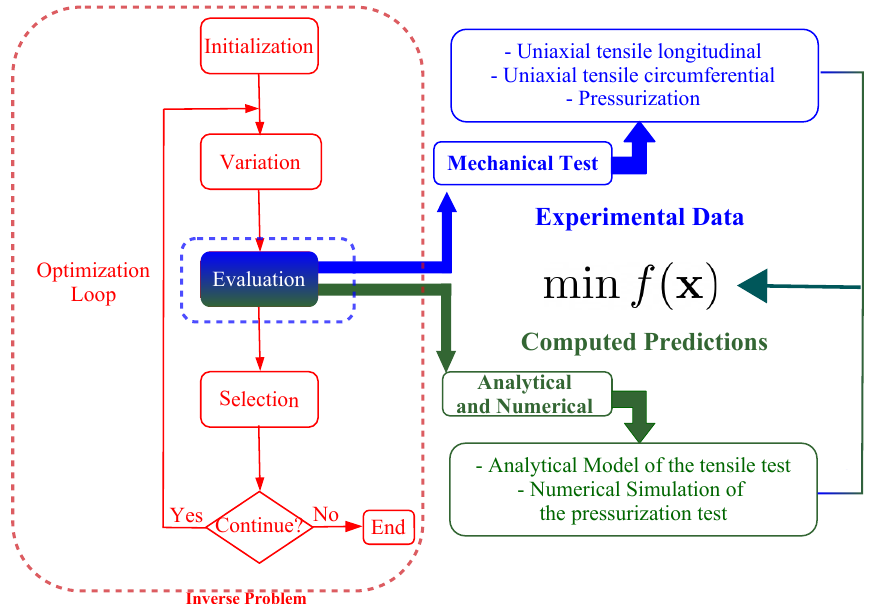
Figure 8. Evolutionary strategy block